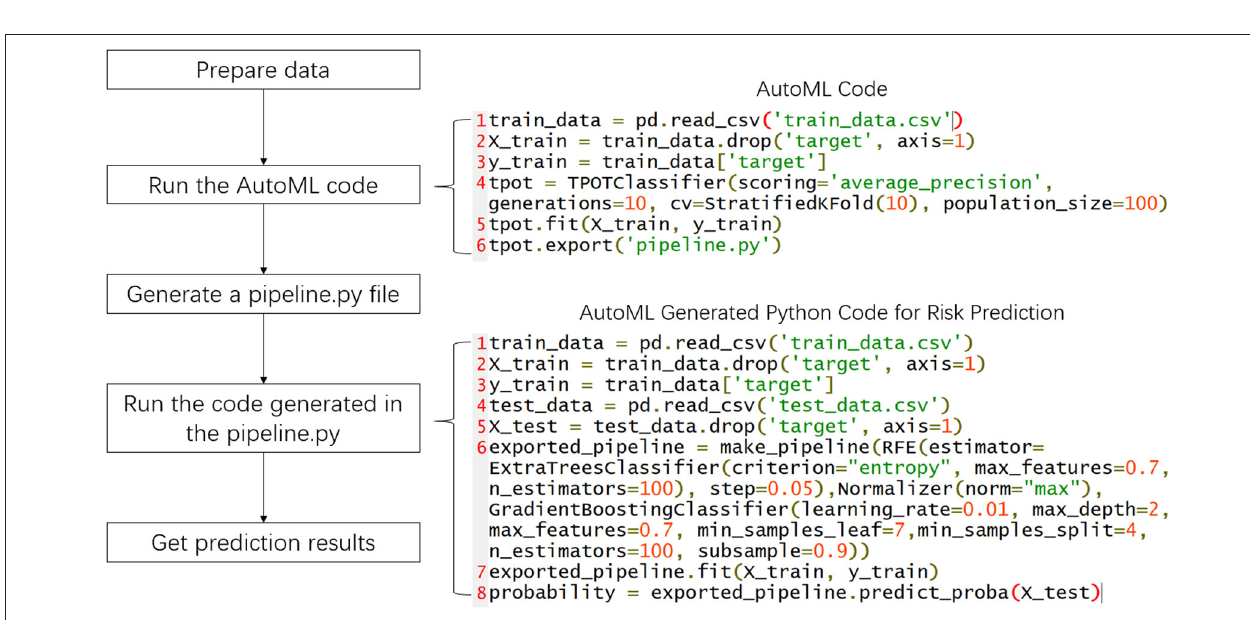
FIGURE 4 | General procedures to apply AutoML in the clinical